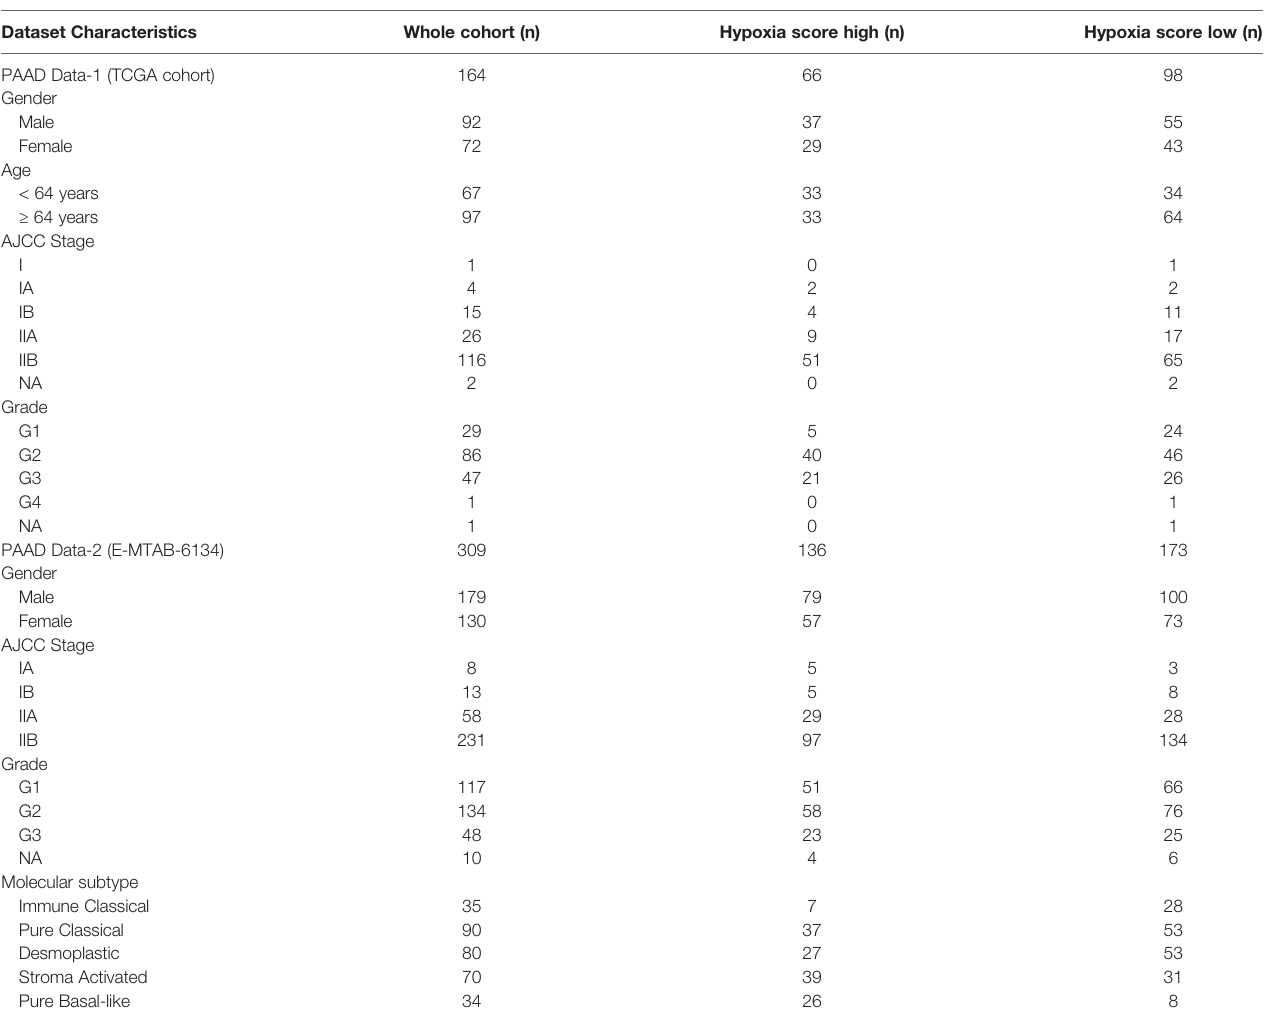
TABLE 1 | Clinical characteristics of hypoxia scored PDA patient